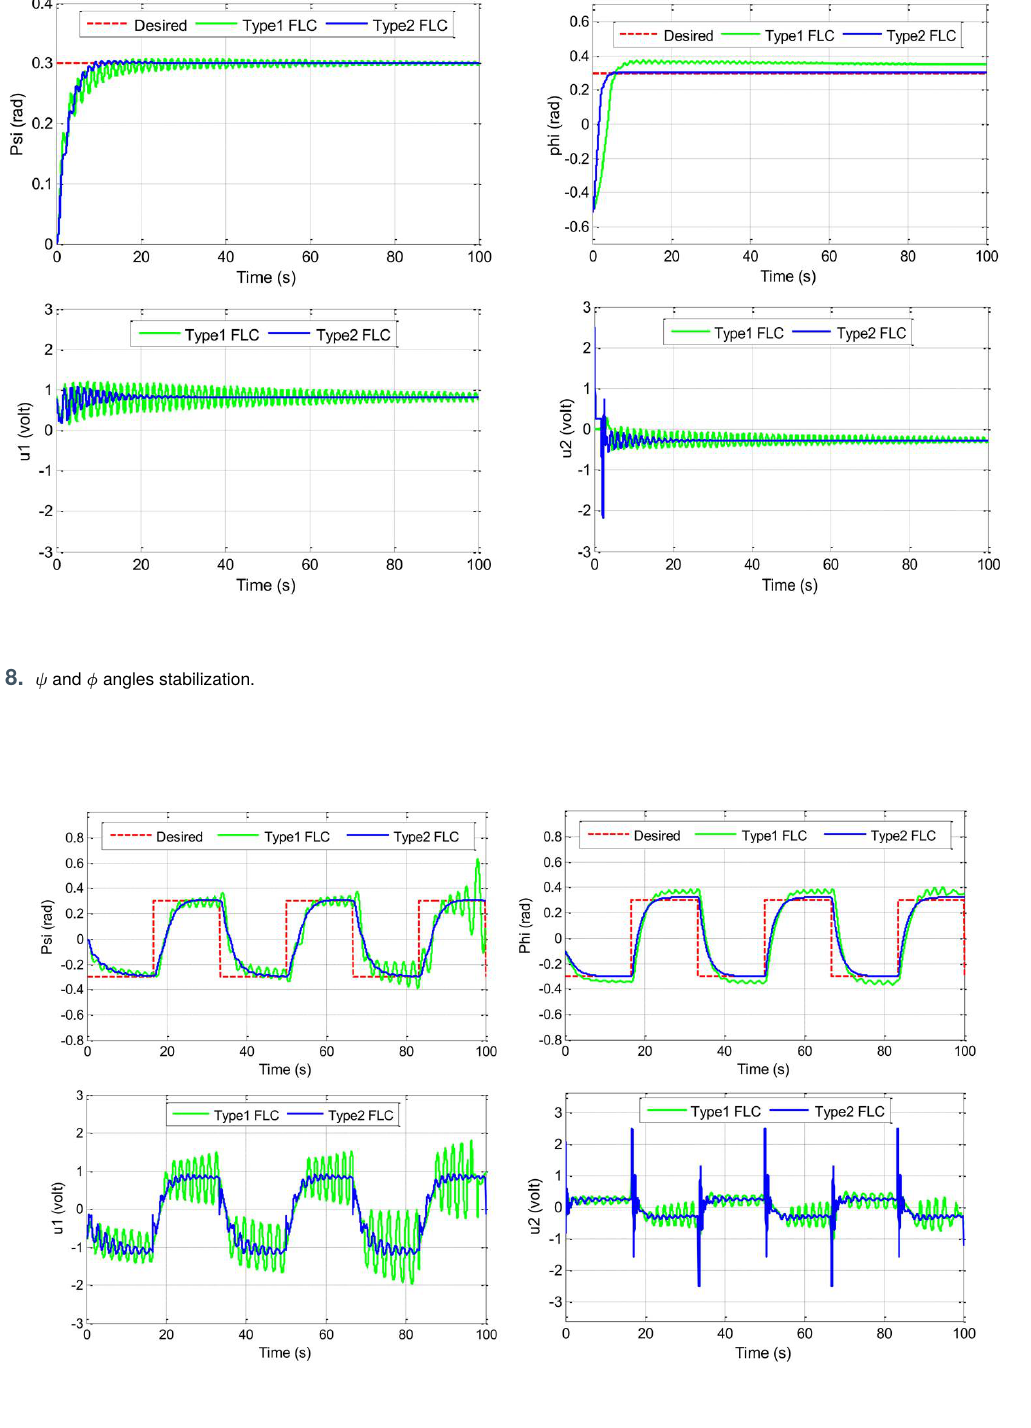
Figure 9. Square wave responses of the